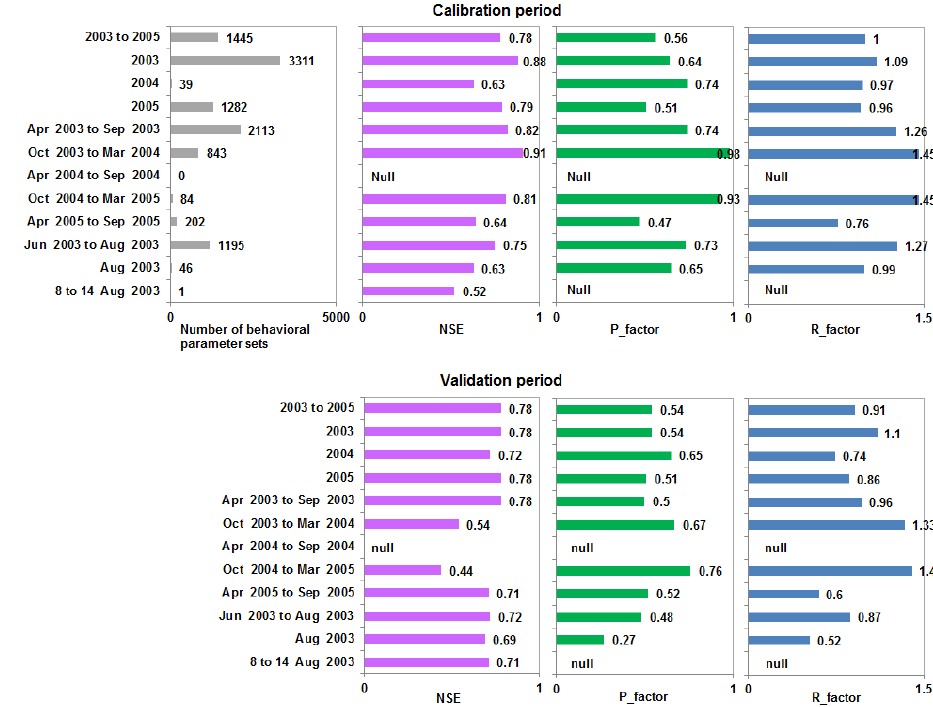
Figure 10. Model performance for the calibrations using short-period data in the Heihe